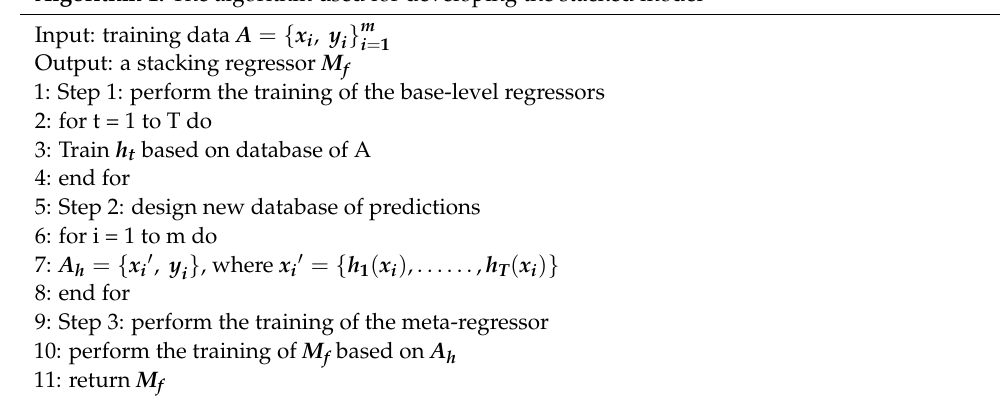
Algorithm 1. The algorithm used for developing the stacked